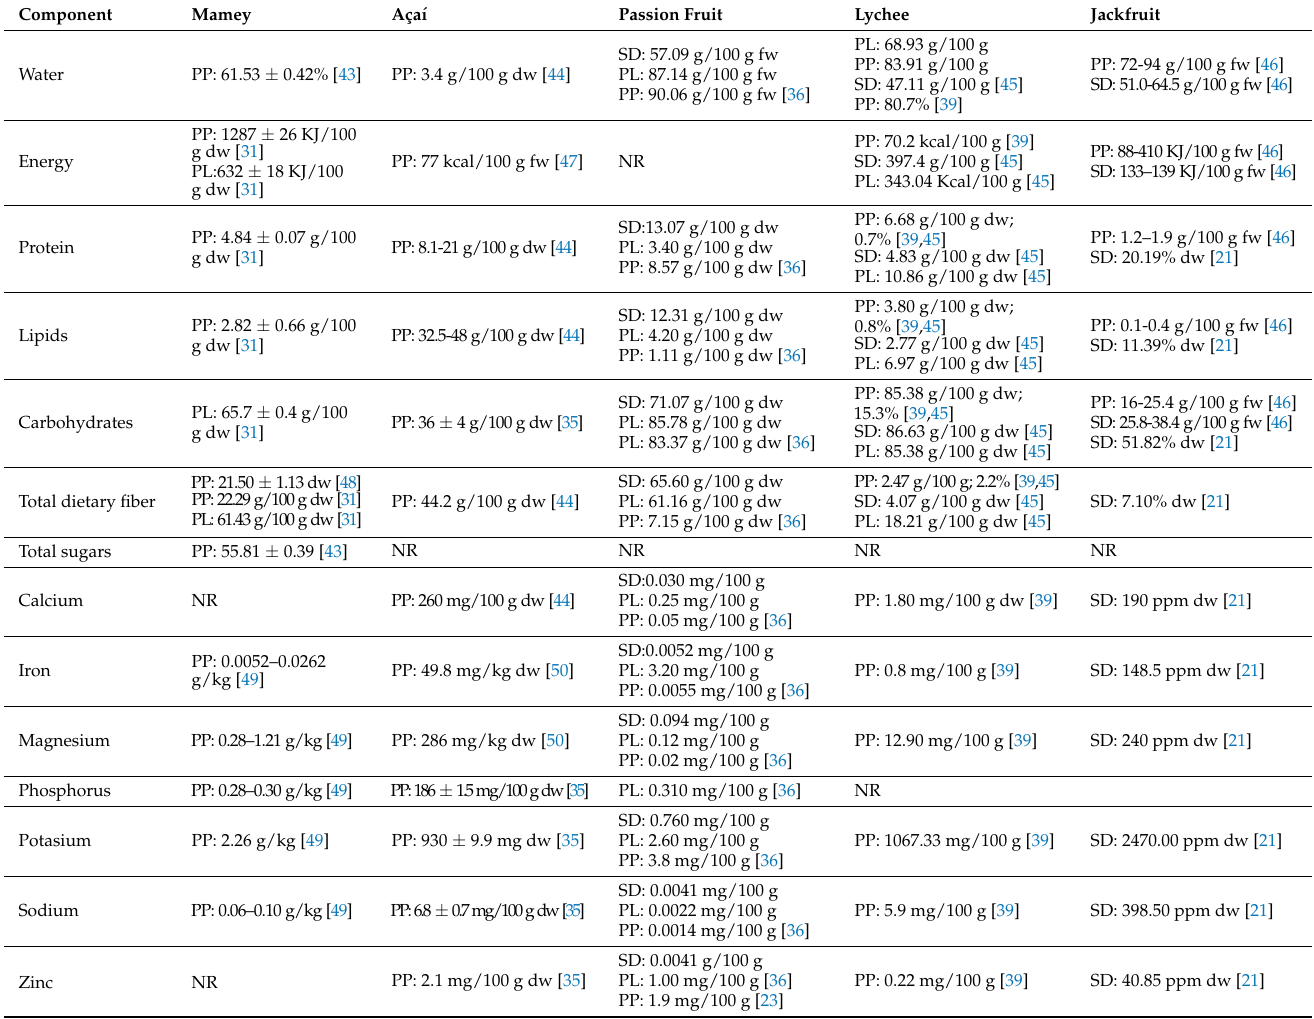
Table 1. Nutritional composition of pulp, seed, and peel of mamey, aça í , passion fruit, lychee, and